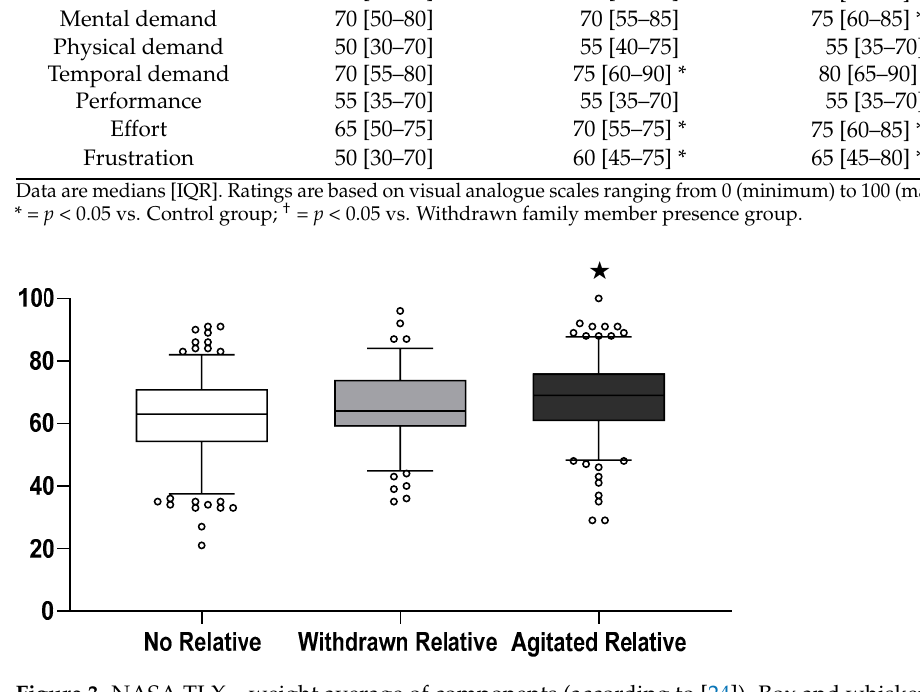
Figure 3. NASA TLX—weight average of components (according to [24]). Box and whisker plot of the perceived overall weighted task load. Boxes depict medians and interquartile range; whiskers outline the 10th and 90th percentile accordingly; circles denote values outside the range from 10th to 90th percentile. Ratings underlying the calculation of the task load are based on visual analogue scales ranging from 0 (minimum) to 100 (maximum). ★ In the agitated relative group, the task load was significantly higher than in the control group ( p < 0.001) and the withdrawn relative group ( p = 0.008). The difference between control and withdrawn relative group was of borderline significance ( p = 0.058).